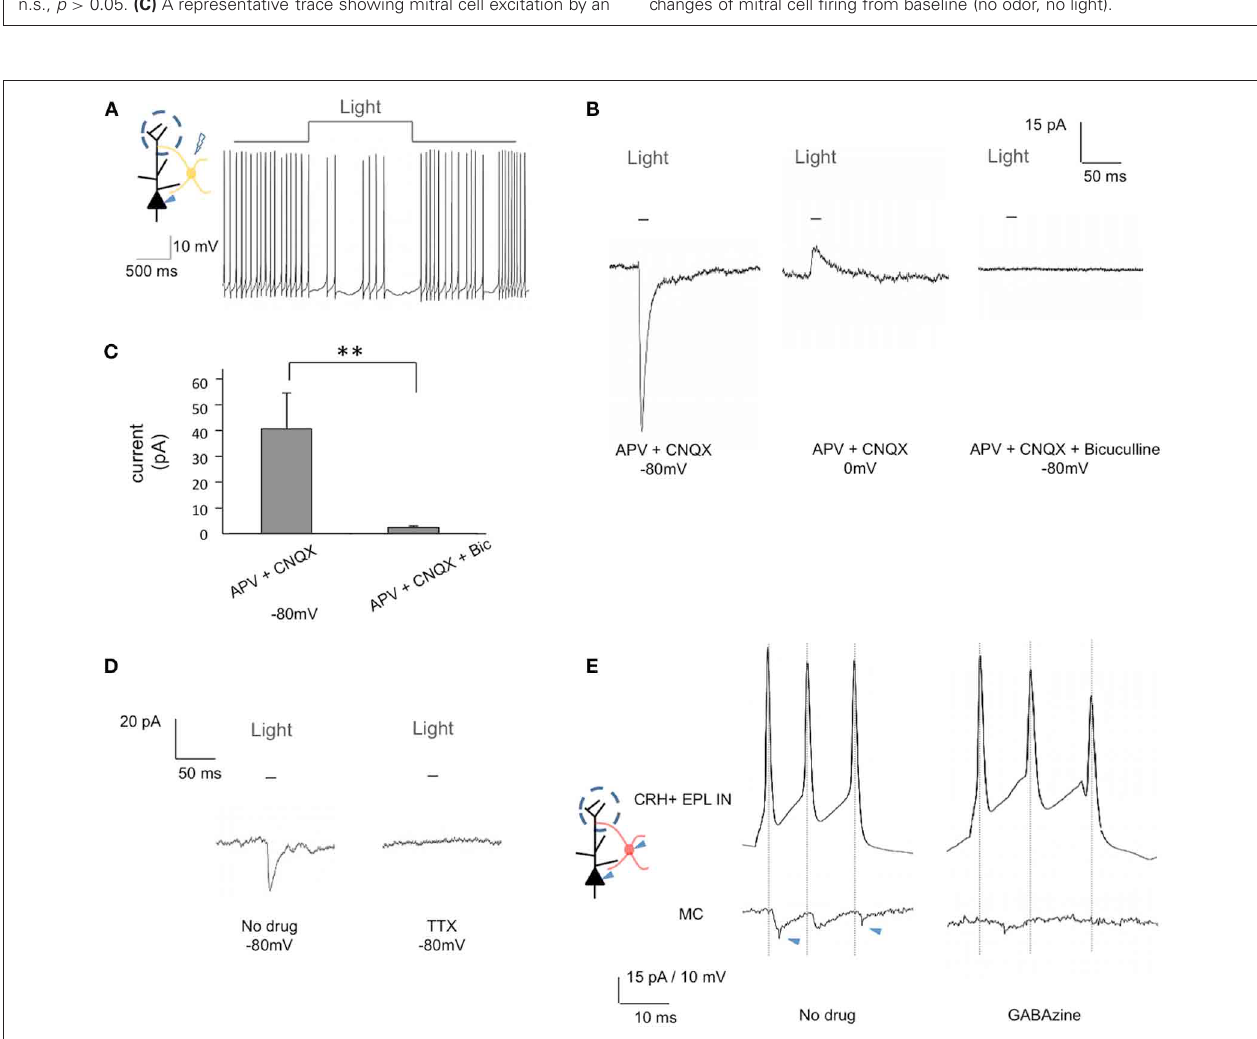
FIGURE 7 | EPL interneurons make inhibitory connections onto mitral cells. (A) and (B) Whole cell recordings from mitral cells in brain slices from CRH-Cre; ROSA-lox-stop-lox-ChR2 mice. (A) Inhibition of mitral cell firing in response to EPL interneuron photostimulation. (B) Recorded GABAergic postsynaptic currents in mitral cells following EPL interneuron photostimulation. The current was inward when the cell was held at − 80mV (left) but changed its direction when the cell was held at 0mV (middle). Resulting photocurrents are refractory to glutamate receptor blockers, but are absent in the presence of Bicuculline (right). Data shown is the average of 10 repeated traces. (C) Average amplitudes of